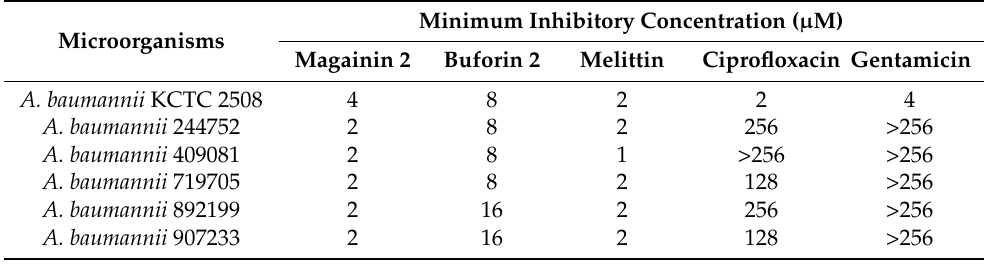
Table 3. Minimum inhibitory concentration (MIC) of peptides and conventional agents against Acinetobacter baumannii strains.